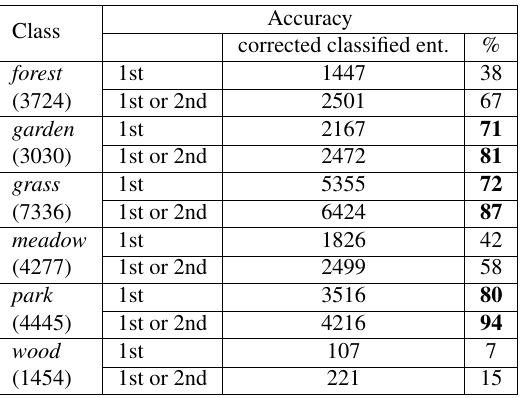
Figure 7: An entity problematic classified as park , 1st recommen- dation